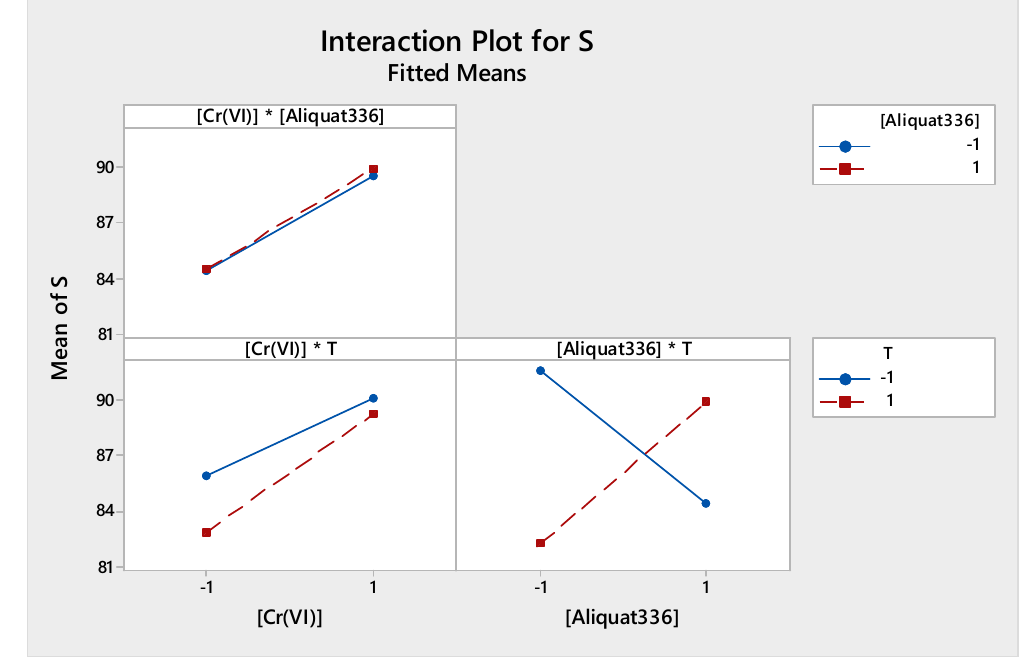
Figure 10. Factors of interactions effects plots for source phase.